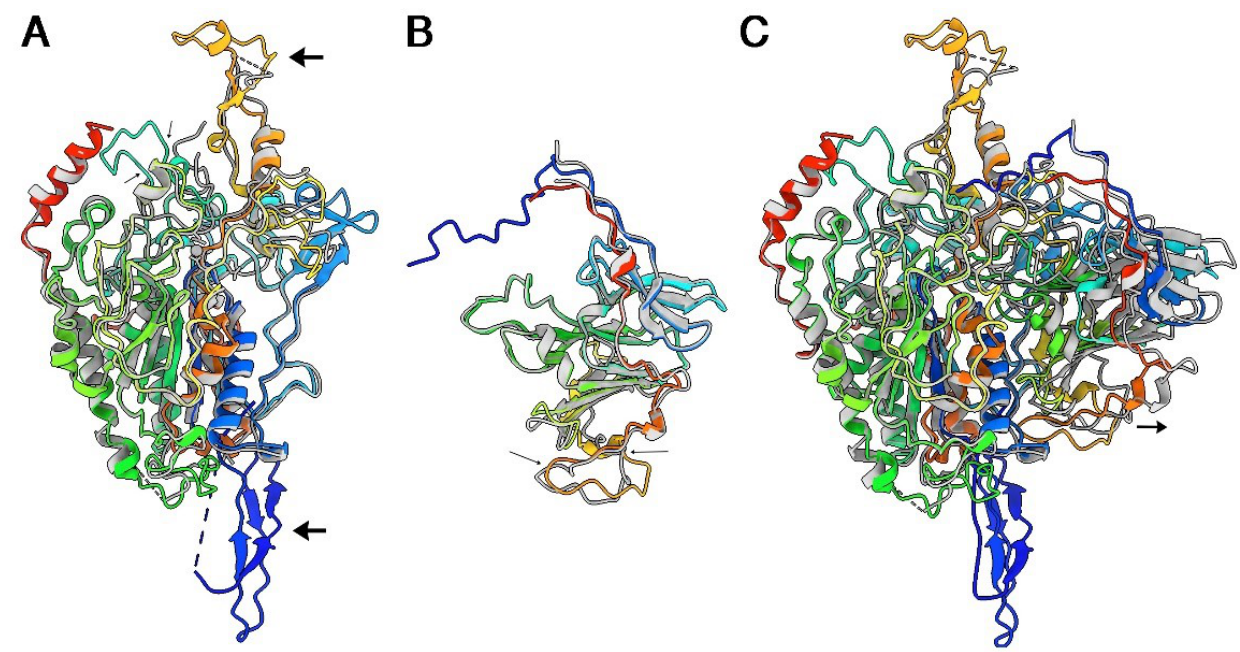
Figure 4. Comparison of X-ray- and AF2-predicted structures. Superposed ribbon views of ( A ) Tle3 AIEC , ( B ) Tli3 AIEC and ( C ) Tle3 AIEC /Tli3 AIEC complex. The small arrow indicates the positional difference between the X-ray structure and the predicted structure. ( A – C ) The X-ray structures are colored grey and the predicted structures are rainbow-colored.